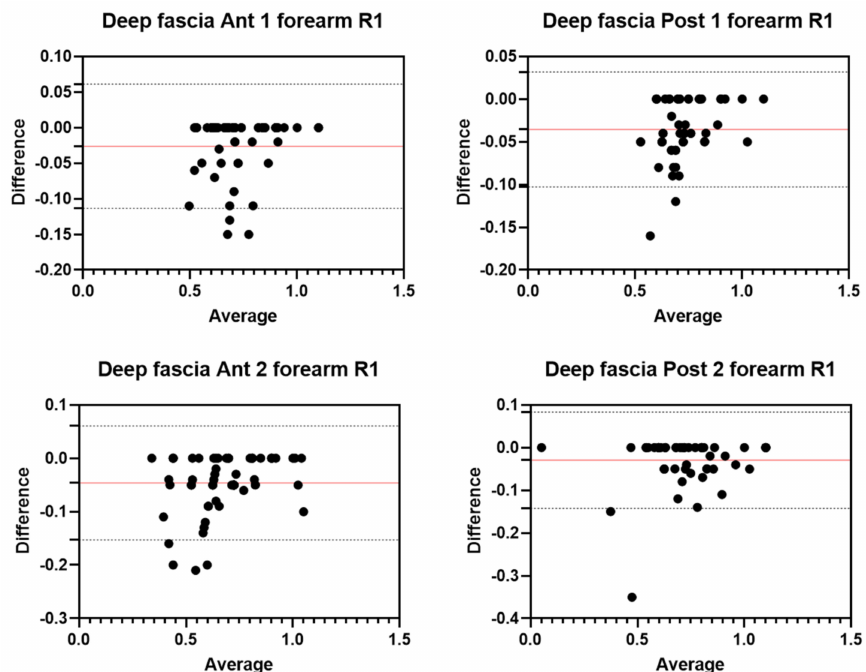
Figure 5. Bland–Altman plot comparing two sessions of Rater 1 (R1) measuring the US thickness of the deep fascia of the forearm for the different levels. Red line = bias or mean difference; dashed lines: 95% limits of agreement (LoAs).